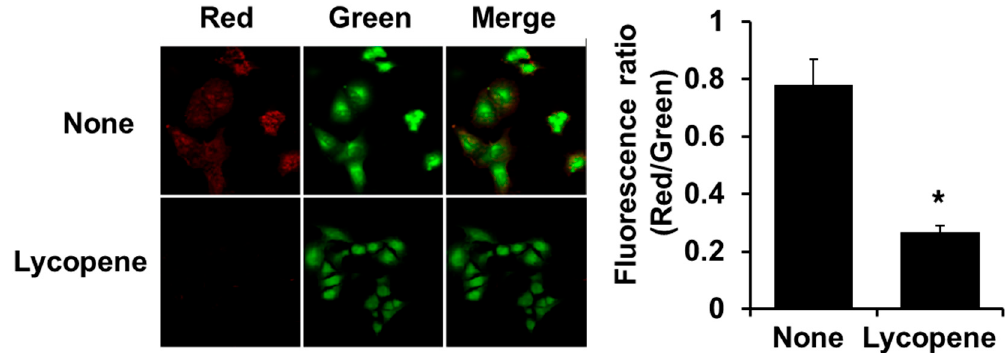
Figure 3. Lycopene decreased MMP in PANC-1 cells. Cells were treated with 0.5 μ M for 24 h. The loss of MMP was examined using JC-1 staining. ( A ) Representative pictures are shown. JC-1 fluorescent dyes can gather in the matrix of mitochondria and produce red fluorescence. As the MMP decreased, JC-1 cannot gather the matrix and thus, JC-1 exists in the matrix as monomer, generating green fluorescence. ( B ) The ratio of the red and green fluorescence density is shown. Data are the mean ± S.E. of four different experiments. * p < 0.05 vs. the “None”. “None” corresponds to the untreated cells; “Lycopene” corresponds to the cells treated with 0.5 μ M lycopene.